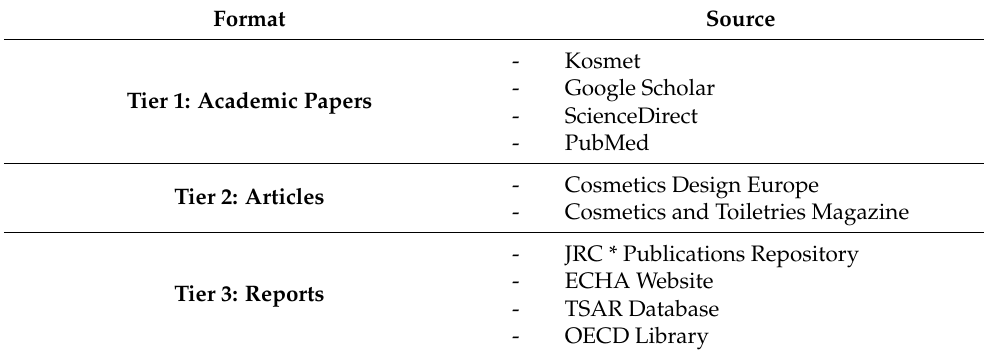
Table 1. Literature sources used for this review.